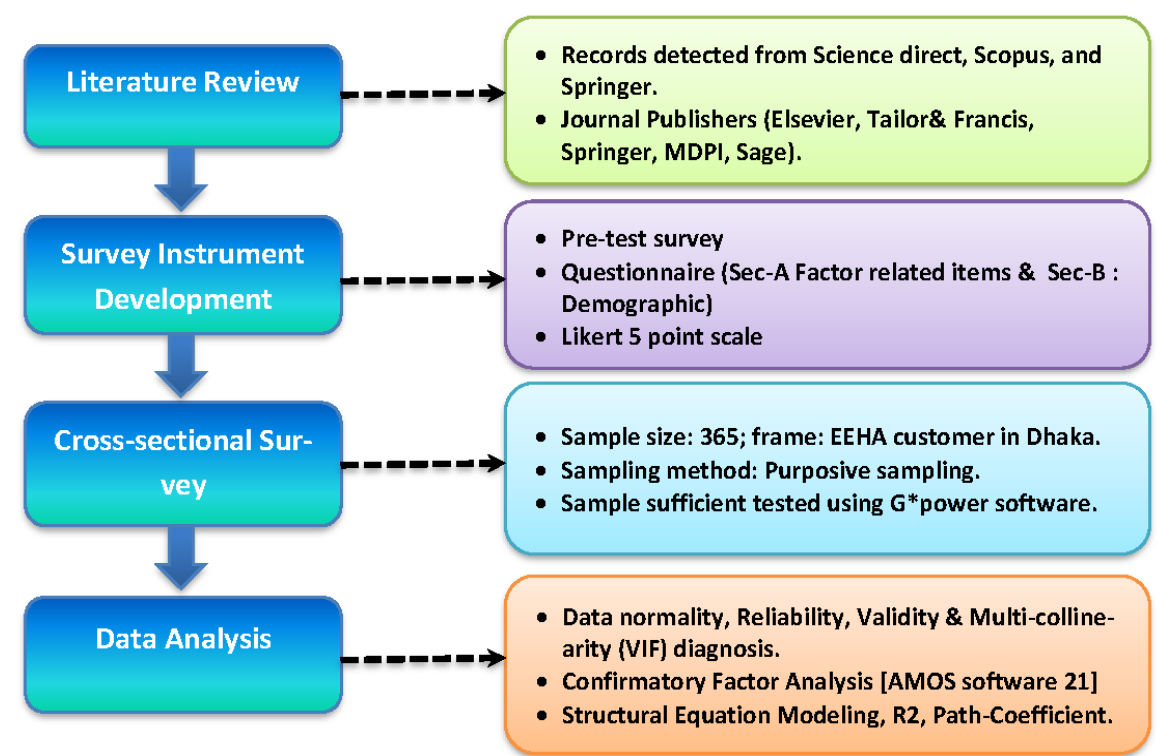
Figure 2. Flowchart of Research Methodology [Source: authors’ illustration] .